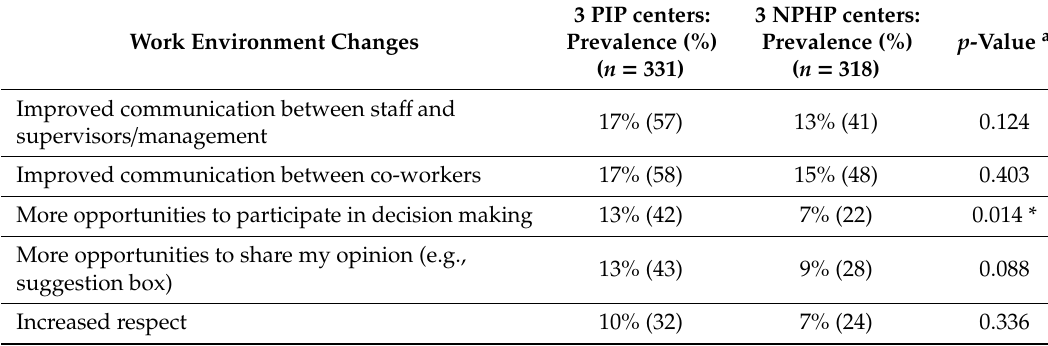
Table 4. Comparison of post-intervention survey responses between PIP and NPHP centers regarding changes in the work environment since the program